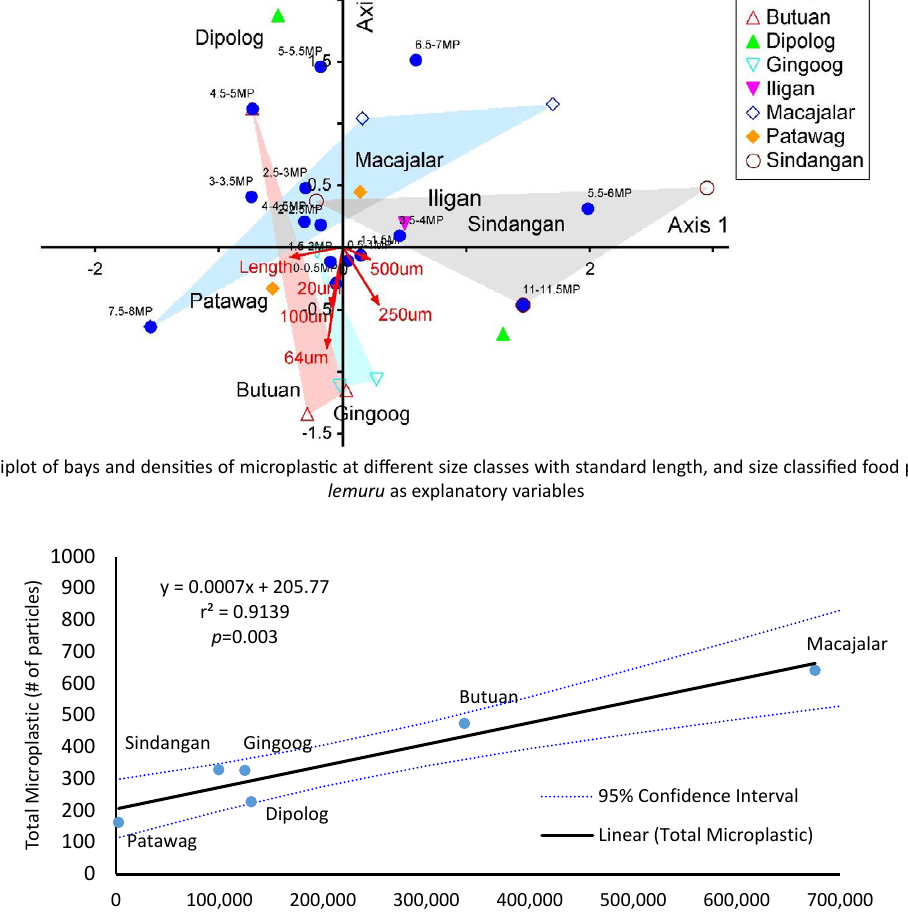
Fig. 6: Relationship of the total ingested microplastics in sardines and the human population in the respective landing sites along Northern Mindanao